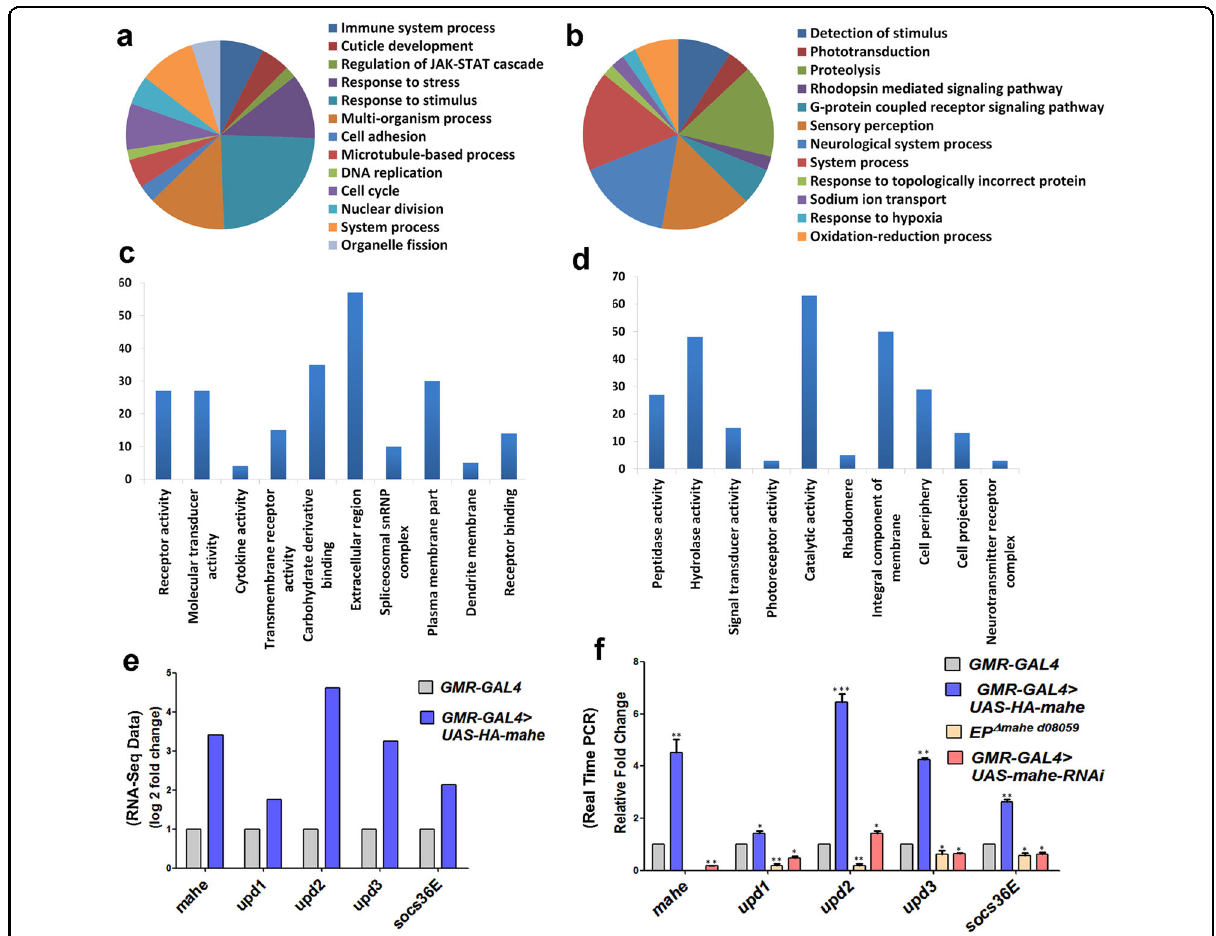
Fig. 1 mahe promotes upregulation of members of JAK/STAT pathway as revealed by transcriptome analysis. Transcriptome analysis was done of eye tissue overexpressing mahe driven with GMR-GAL4 and was compared to GMR-GAL4 controls. a , b Functional categories enriched in upregulated (1080) and downregulated (519) genes based on their molecular functions using DAVID, which includes genes associated with phototransduction, JAK/STAT pathway activation, response to stress, nuclear division, and many more. c , d Enrichment of pathway speci fi c upregulated (1080) and downregulated (519) genes based on their biological and cellular functions using DAVID. e Graph represents selected genes upd1 , upd2 , upd3 and socs36E were differentially expressed in the RNA-Seq data. f Real time PCR validated the candidate genes obtained from our transcriptome analysis data. The components of JAK/STAT signaling pathway were upregulated upon ectopic expression of mahe and were signi fi cantly downregulated in mahe loss-of-function mutant as well as in mahe-RNAi . One-way ANOVA. Genotypes ( a – f ) w/ + ; + ; GMR-GAL4/ + and w/ + ; + ; GMR-GAL4, UAS-HA-mahe/UAS-HA-mahe ( f ) EP Δ mahe d08059 ; + ; + ( f ) + ; UAS-mahe-RNAi/ + ; GMR-GAL4/ + . One-way ANOVA * P < 0.05, ** P < 0.01, *** P <